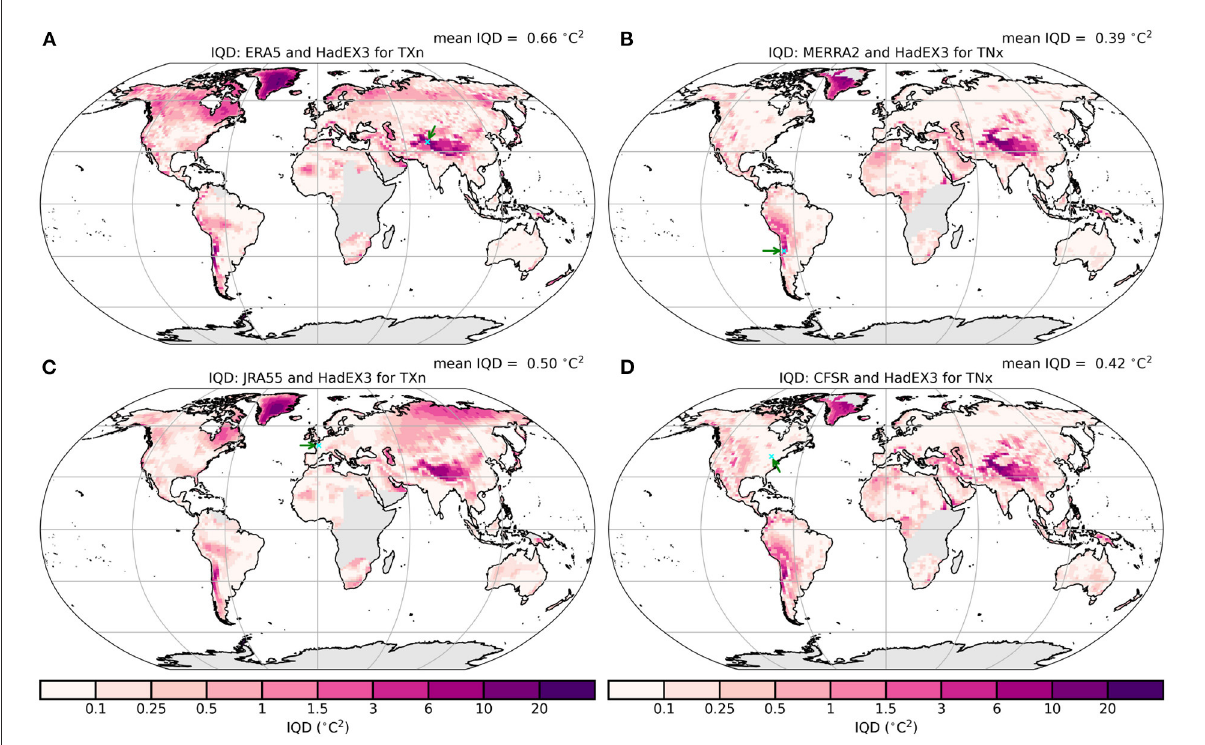
FIGURE5 Integrated quadratic distance (IQD) map between HadEX3 and (A) ERA5 and (C) JRA55 for TXn and (B) MERRA-2 and (D) CFSR for TNx. Small (so as not to distract from the underlying values) blue crosses mark the locations of grid boxes presented in Figure A2, which are also indicated by a green arrow [ (A) northern Indian subcontinent, (B) western South America, (C) France, (D) north-eastern